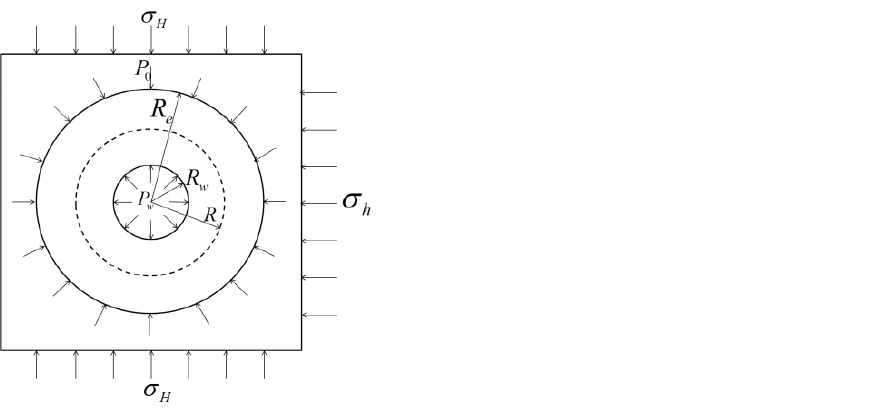
Figure 13. The schematic of stress state surrounding the wellbore during testing of high-pressure gas reservoirs.